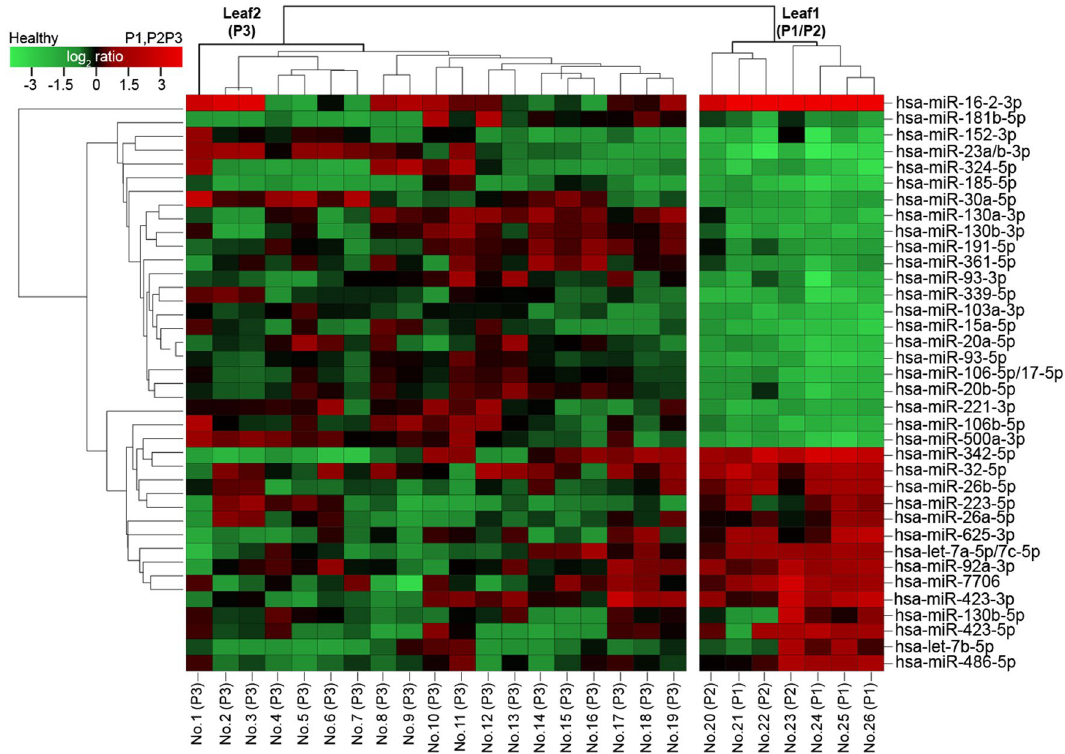
Figure 3. DEMs measured in the whole blood of HO patients diagnosed with or without IA. Hierarchical clustering was performed using the log 2 -transformed relative read counts of the 36 DEMs selected on the basis of the differential expression analysis in HO patients demonstrating a fold change difference greater than 2, P < 0.01 relative to healthy controls. Euclidian distances revealed two main clusters: Leaf 1 and Leaf 2. Leaf 1 represents patients with high-risk IA (HO-proven IA and HO-probable IA). Leaf 2 represents patients with low- risk IA (HO-possible